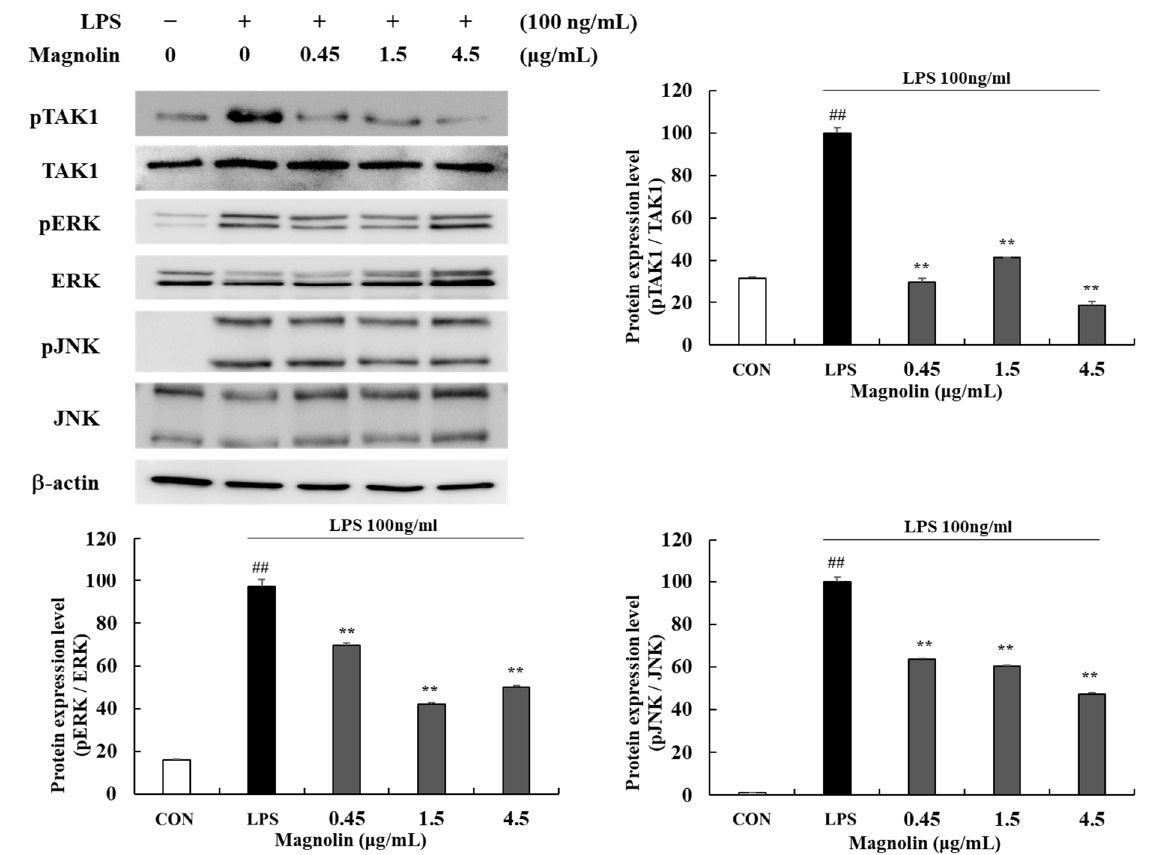
Figure 11. Effects of magnolin (0.45, 1.5, and 4.5 μg/mL) on the production of pTAK1 and MAPK factors in LPS-stimulated RAW 264.7 cells. Magnolin and 100 ng/mL of LPS was added except for in the vehicle control group and incubated at 37 °C for 15 min. Protein expression levels of pTAK1, TAK1, pERK, ERK, pJNK, JNK were detected by Western blot. Values represent means ± standard deviation. ## p < 0.01 vs. Vehicle control group; ** p < 0.01 vs. LPS-activated control group.